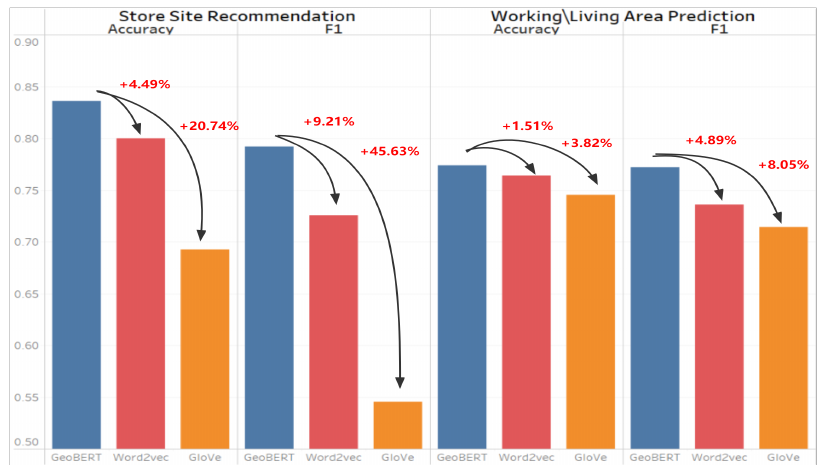
Figure 10. Results of classification tasks. Word2vec and GloVe still achieve good results. GeoBERT leads Word2vec by 4.49% in Accuracy for the store site recommendation task and 1.51% for the working \ living area prediction task.